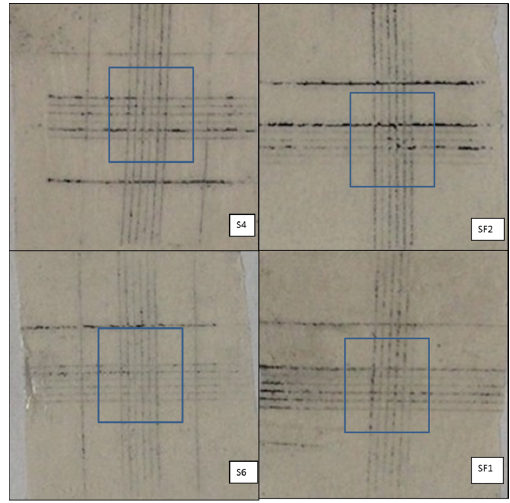
Figure 1. Prints of cross ‐ cut area on tape before thermal treatment (the clearness is worsened by the glue layer).